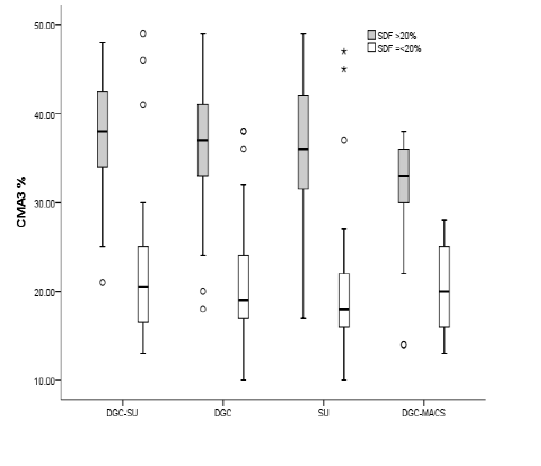
Figure 1. Values of CMA3+ % ( a ) from neat semen samples and ( b ) measured after spermatozoa selection using DGC-SU, DGC, SU and DGC-MACS. Semen samples separated here by ≤20 and >20% SDF. ** p < 0.01, *** p < 0.001. The ART cycle parameters and outcome of sperm preparation (DGC, SU, DGC-SU and DGC-MACS) techniques are reported in Figure 2. There was a significant ( p < 0.05) Men with Normal and Increased Sperm DNA Fragmentation increase in cleavage rate in the DGC MACS group. All other parameters are comparable between all preparation groups. The DGC-MACS group had significantly ( p < 0.01) improved cleavage rates in both SDF was ≤ 20% and >20% cohorts, whereas there was no difference in the live implantation rate in both SDF cohorts (Table 5, Figure 3).